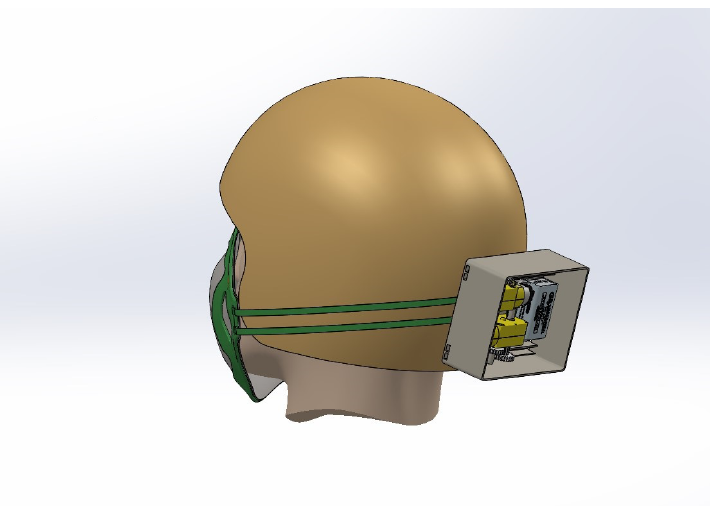
Figure 7. 3D design of person wearing mask brace.